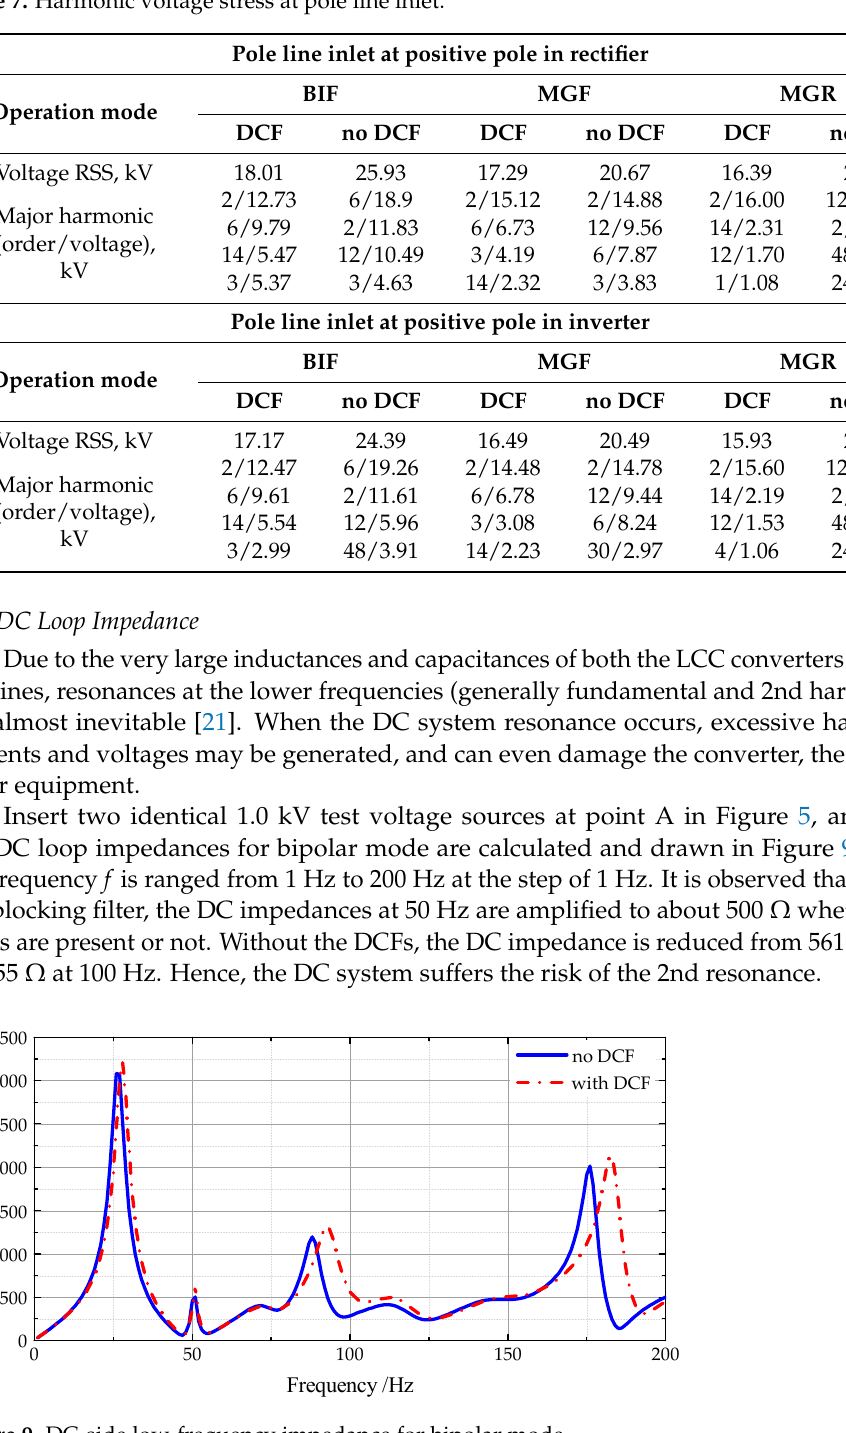
Figure 9. DC-side low-frequency impedance for bipolar mode.